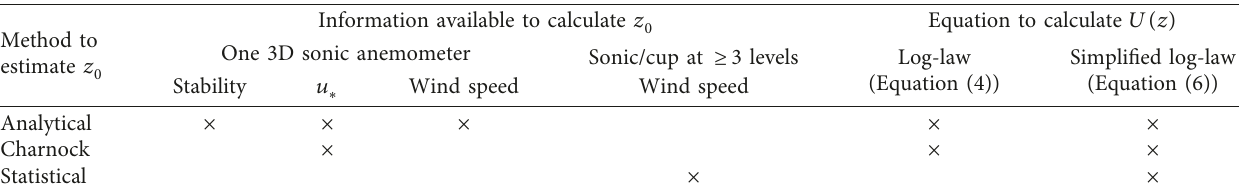
Table 3: Information used to calculate z profile U ( z )